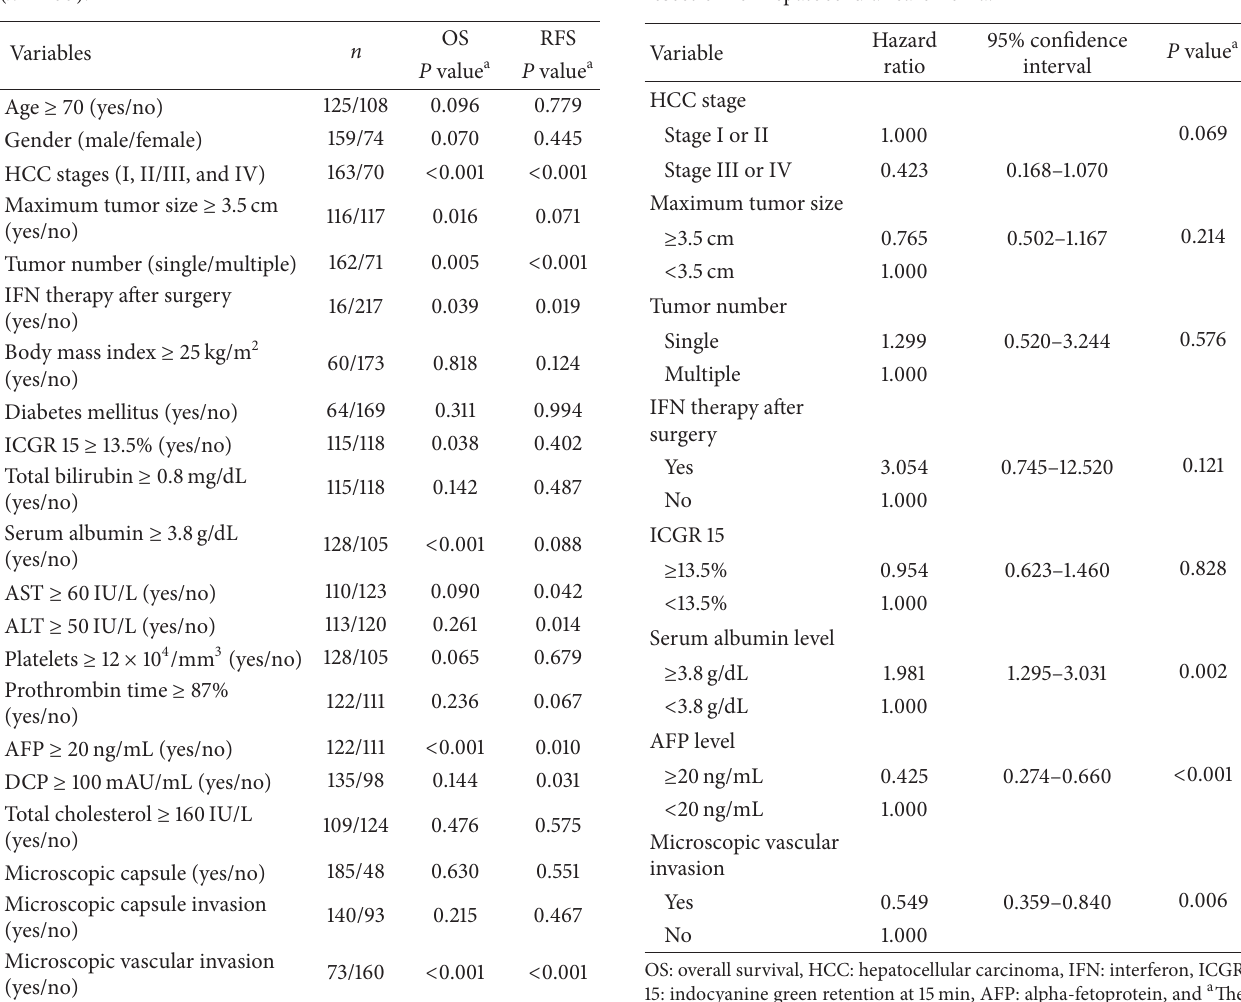
Table 2: Univariate analysis contributing to OS and RFS for all cases ( 𝑛 = 233 ).